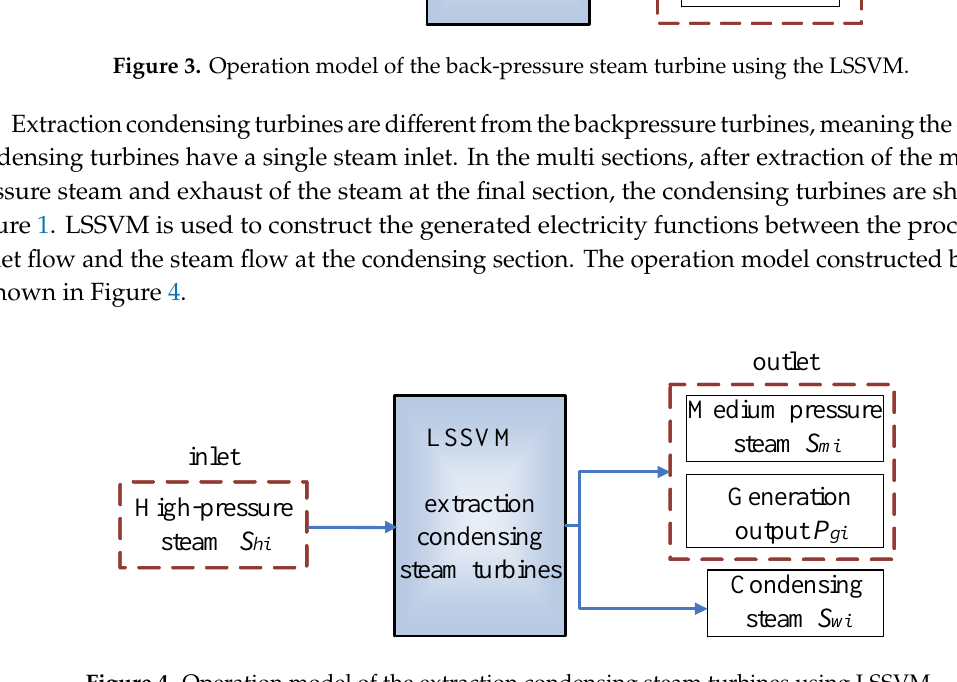
Figure 4. Operation model of the extraction condensing steam turbines using LSSVM.